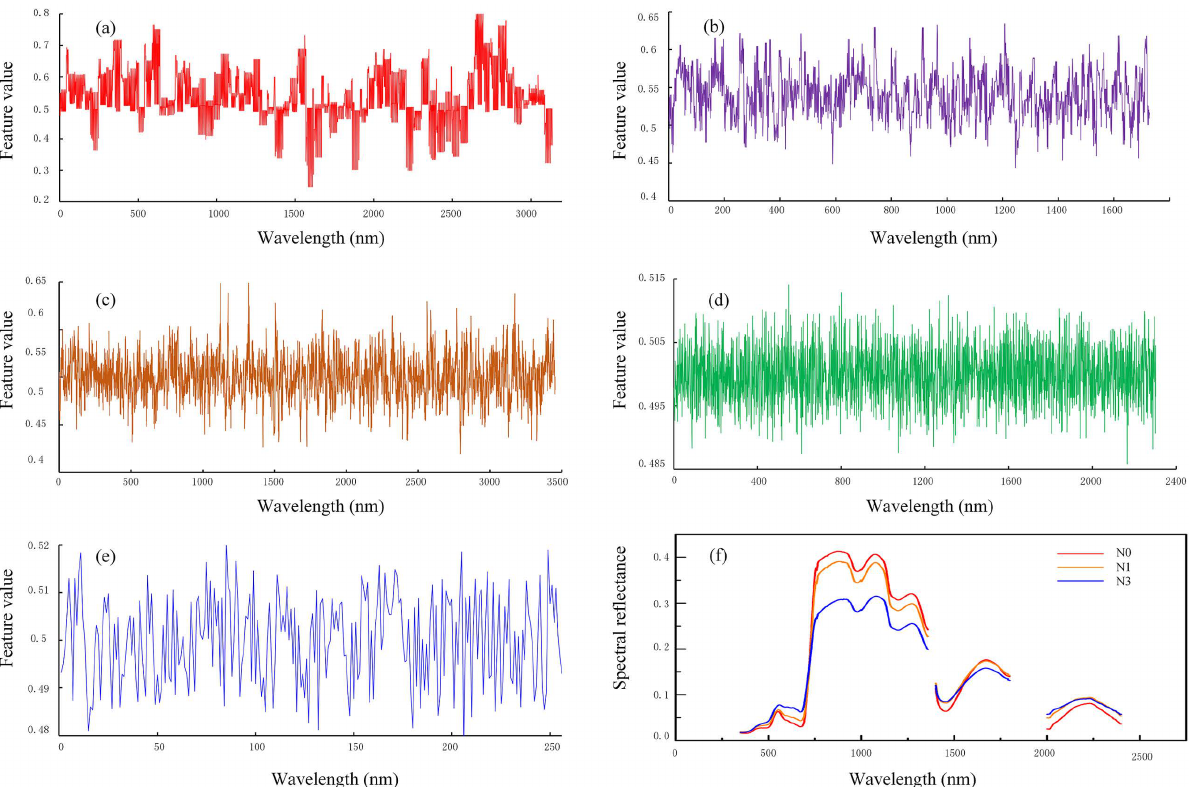
Figure 8. Original spectrum and convolutional features of different convolutional layers, including output features of ( a ) the first, ( b ) the second, ( c ) the third, ( d ) the fourth, and ( e ) the fifth convolutional layer, ( f ) the raw spectral data of the wheat